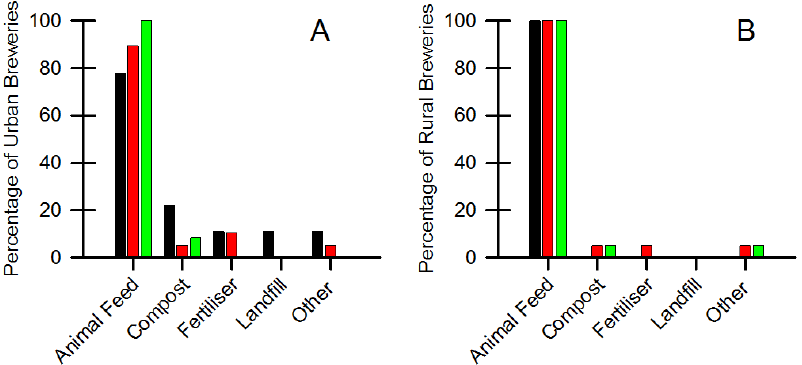
Figure 3. Spent grain disposal method in urban and rural based craft breweries. ( A ) Urban-based craft brewers; ( B ) rural-based craft breweries. Black bars: breweries with a batch capacity smaller than 1000 L; red bars: breweries with a batch capacity greater than 1000 L, but smaller than 2000 L; and green bars: breweries with a batch capacity greater than 2000 L. Total figures might add up to over 100% because some breweries employ multiple methods of